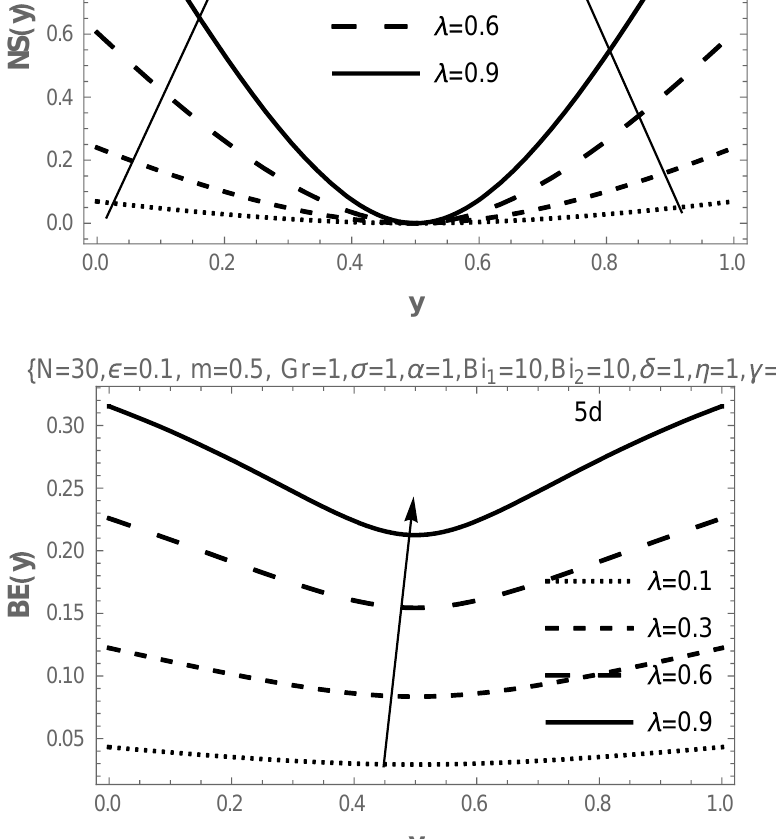
Figure 5. Variations in Frank‑Kameneskii